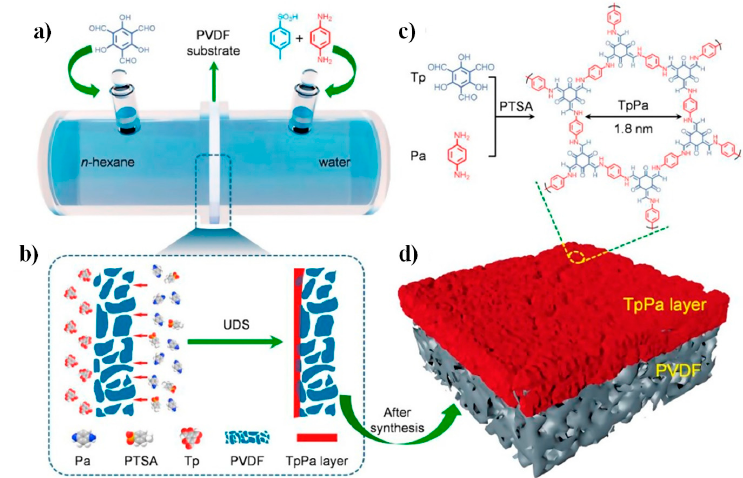
Figure 12. Schematic illustration of the preparation process of the COF-based membranes via the UDS method. ( a ) Schematic illustration of a diffusion cell for the COF growth by UDS. ( b ) Schematic illustration of the formation of the COF layer on the top side of PVDF support via unidirectional diffusion of Pa-1 and PTSA molecules through the pores of the PVDF support to react with the Tp molecules. ( c ) Synthesis of the COF through the condensation of Tp and Pa-1. ( d ) The schematic illustration of intergrowth appearance of COF / PVDF membranes after synthesis. Reprinted with permission from [73]. Copyright (2019) Elsevier